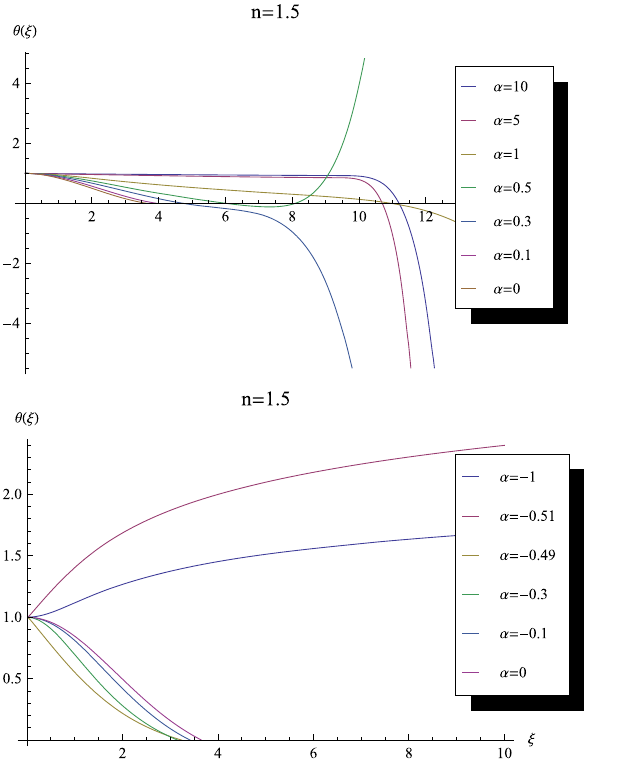
Fig. 2 Plotsofthenumericalsolutionsforthecase n = 1 . 5forpositive (top) and negative (bottom) values of the parameter α